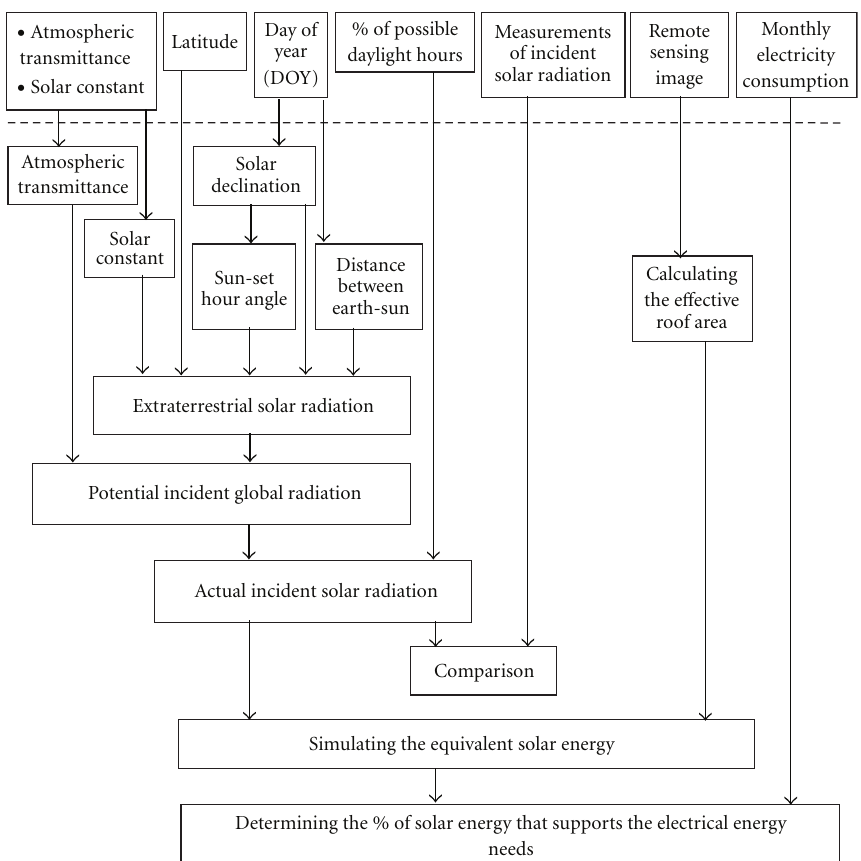
Figure 2: Schematic diagram of the steps employed in this study for modelling solar energy over the portion of Sandstone community in northwest of Calgary in the Canadian Province of